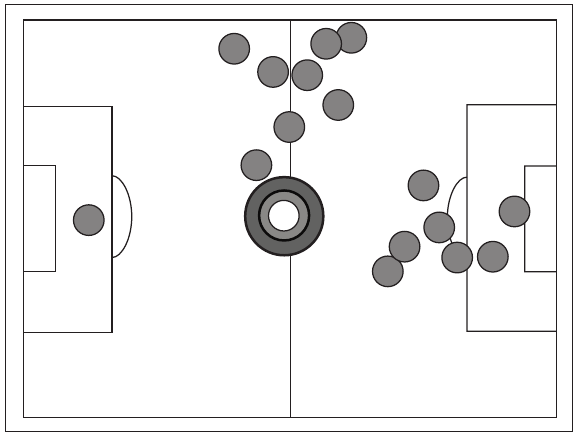
Figure 9: Real-time analysis of moving targets under CAD-assisted intelligent technology. Table 4: Analyze the performance comparison of CAD-assisted intelligent technology. CAD-assisted intelligent